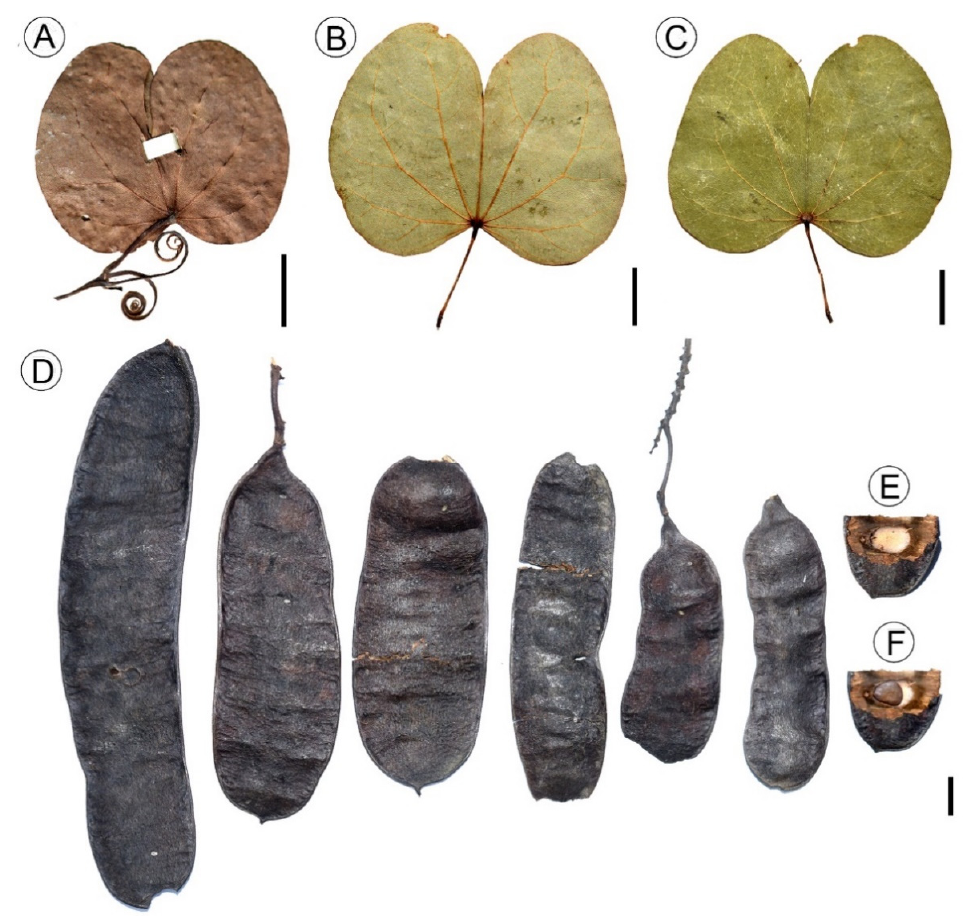
Figure 10. Morphology of Bauhinia damiaoshanensis T. Chen leaf ( A ) and Bauhinia touranensis Gagnep. leaves and fruits ( B – F ). The bars are 1 cm.